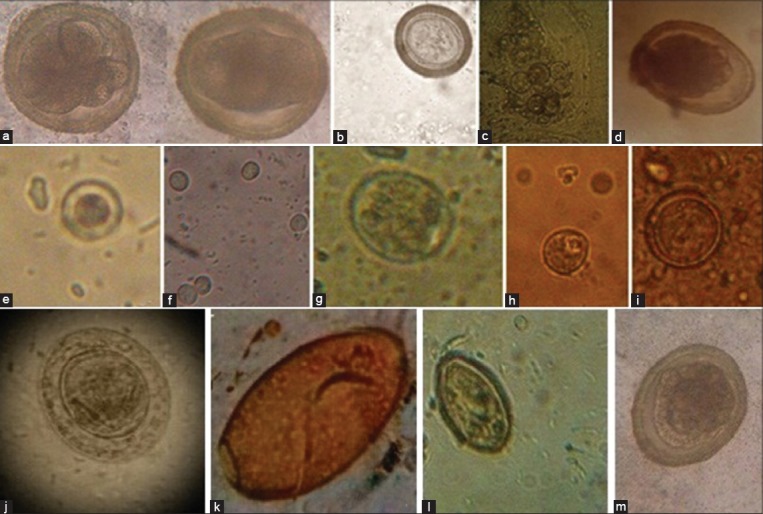
The identified enteric parasites. (a) Ancylostoma eggs, (b) Taenia eggs, (c) Dipylidium caninum eggs, (d) Ascaris lumbercoides eggs, (e) Blastocystis hominis, (f) Cryptosporidium oocyst, (g) Cyclospora caytanesis, (h) Entamobea canis, (i) Toxocara leonina, (j) Hymenolepis nana, (k) Paragonimus westermani, (l) Heterophyes eggs, (m) Toxocara canis eggs.